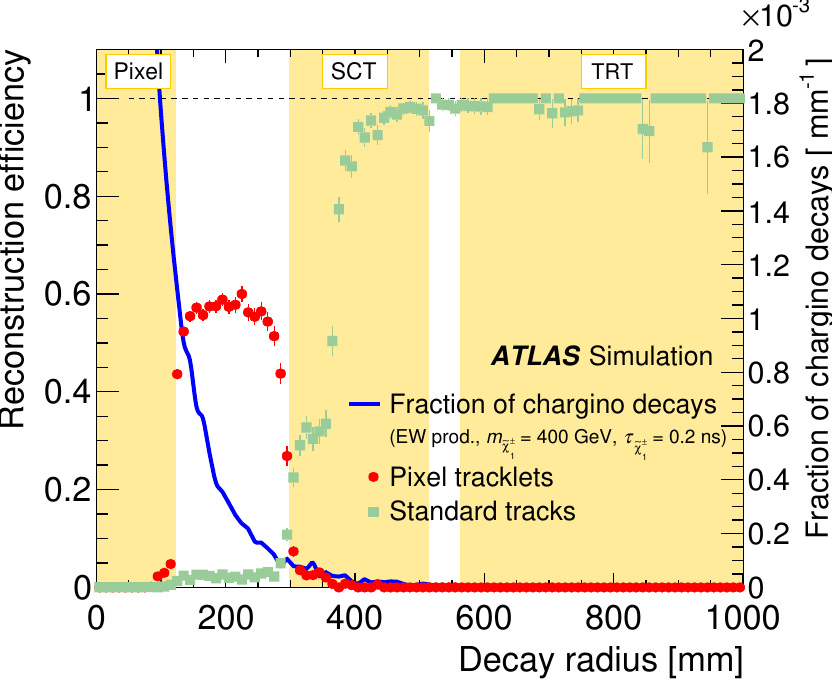
Figure 4 . Chargino reconstruction e(cid:14)ciency as a function of decay radius. The reconstruction e(cid:14)ciency of pixel tracklets before applying the fake-rejection criteria is shown in red, while that obtained with the standard tracking algorithm is shown in green. The error bars show statistical uncertainties in the estimation. Also shown in blue, on the right axis, is the distribution of the decay radius for charginos with a lifetime of 0.2 ns. The yellow shaded regions correspond to the coverage of each